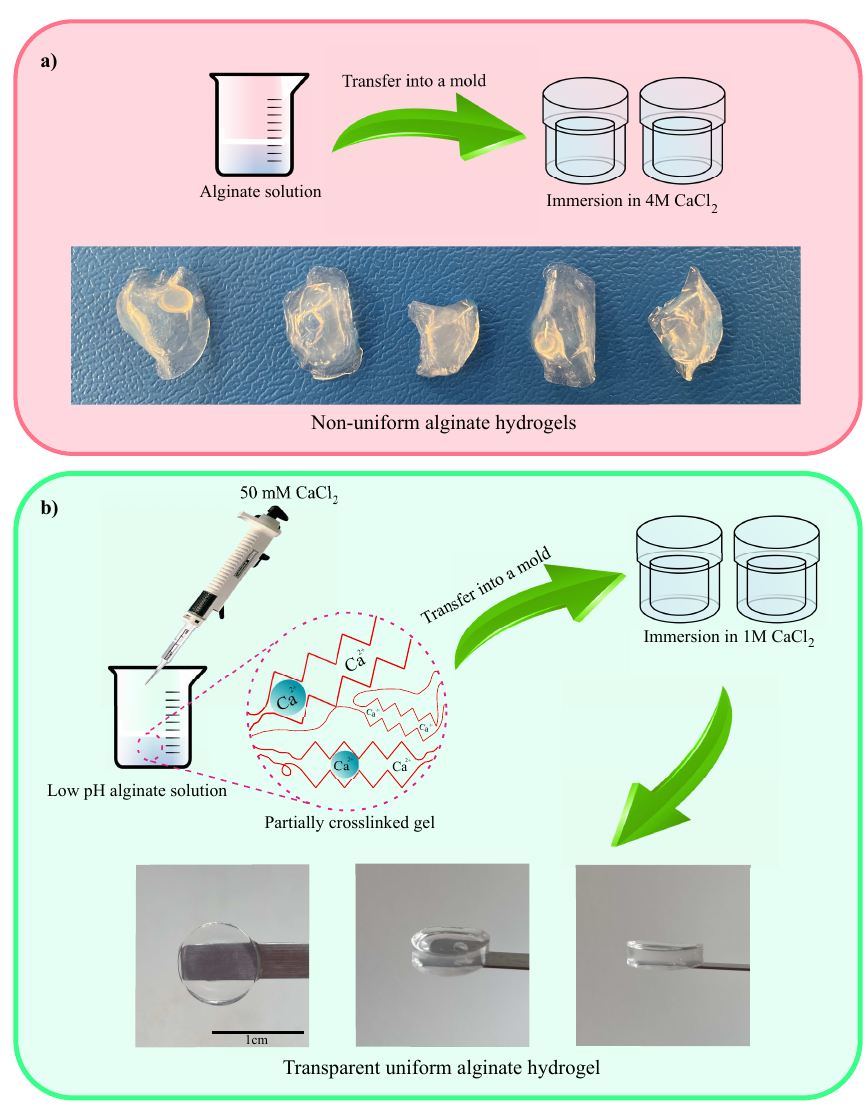
Figure 1. Preparation of alginate gels ( a ) by the conventional method, ( b ) by the method proposed in this